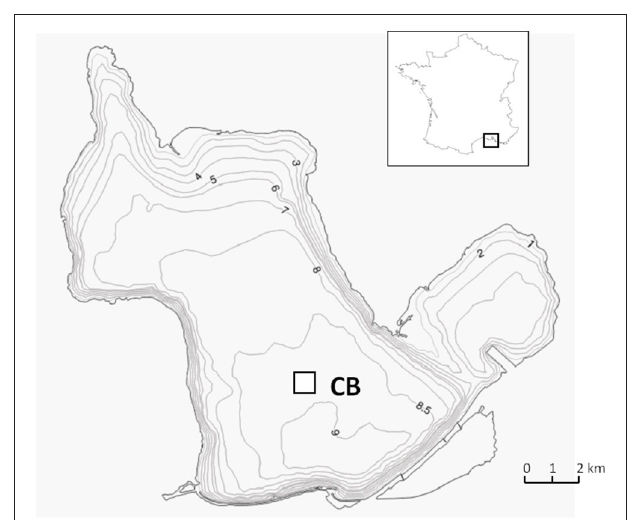
FIGURE 2 | Map of the Berre lagoon and sampling